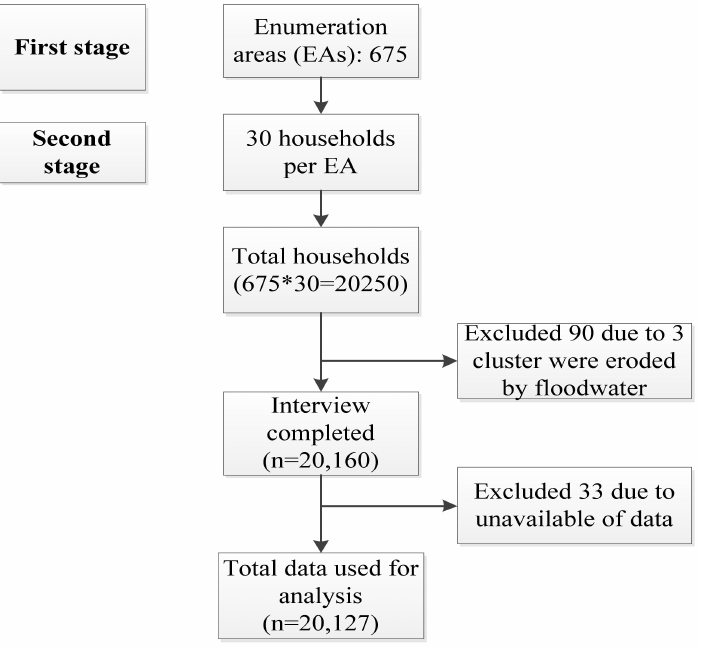
Figure 1. Sampling frame, BDHS2017–2018. Weight measurement using the lightweight scale SECA787 (with digital